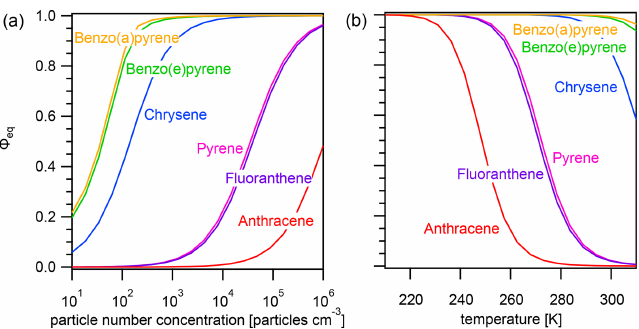
Figure A2. Equilibrium particulate fraction (cid:56) eq of selected PAHs as a function of (a) particle number concentration ( T = 298K) and (b) temperature ( N p = 1 × 10 3 ) for particles of size d p = 50nm.